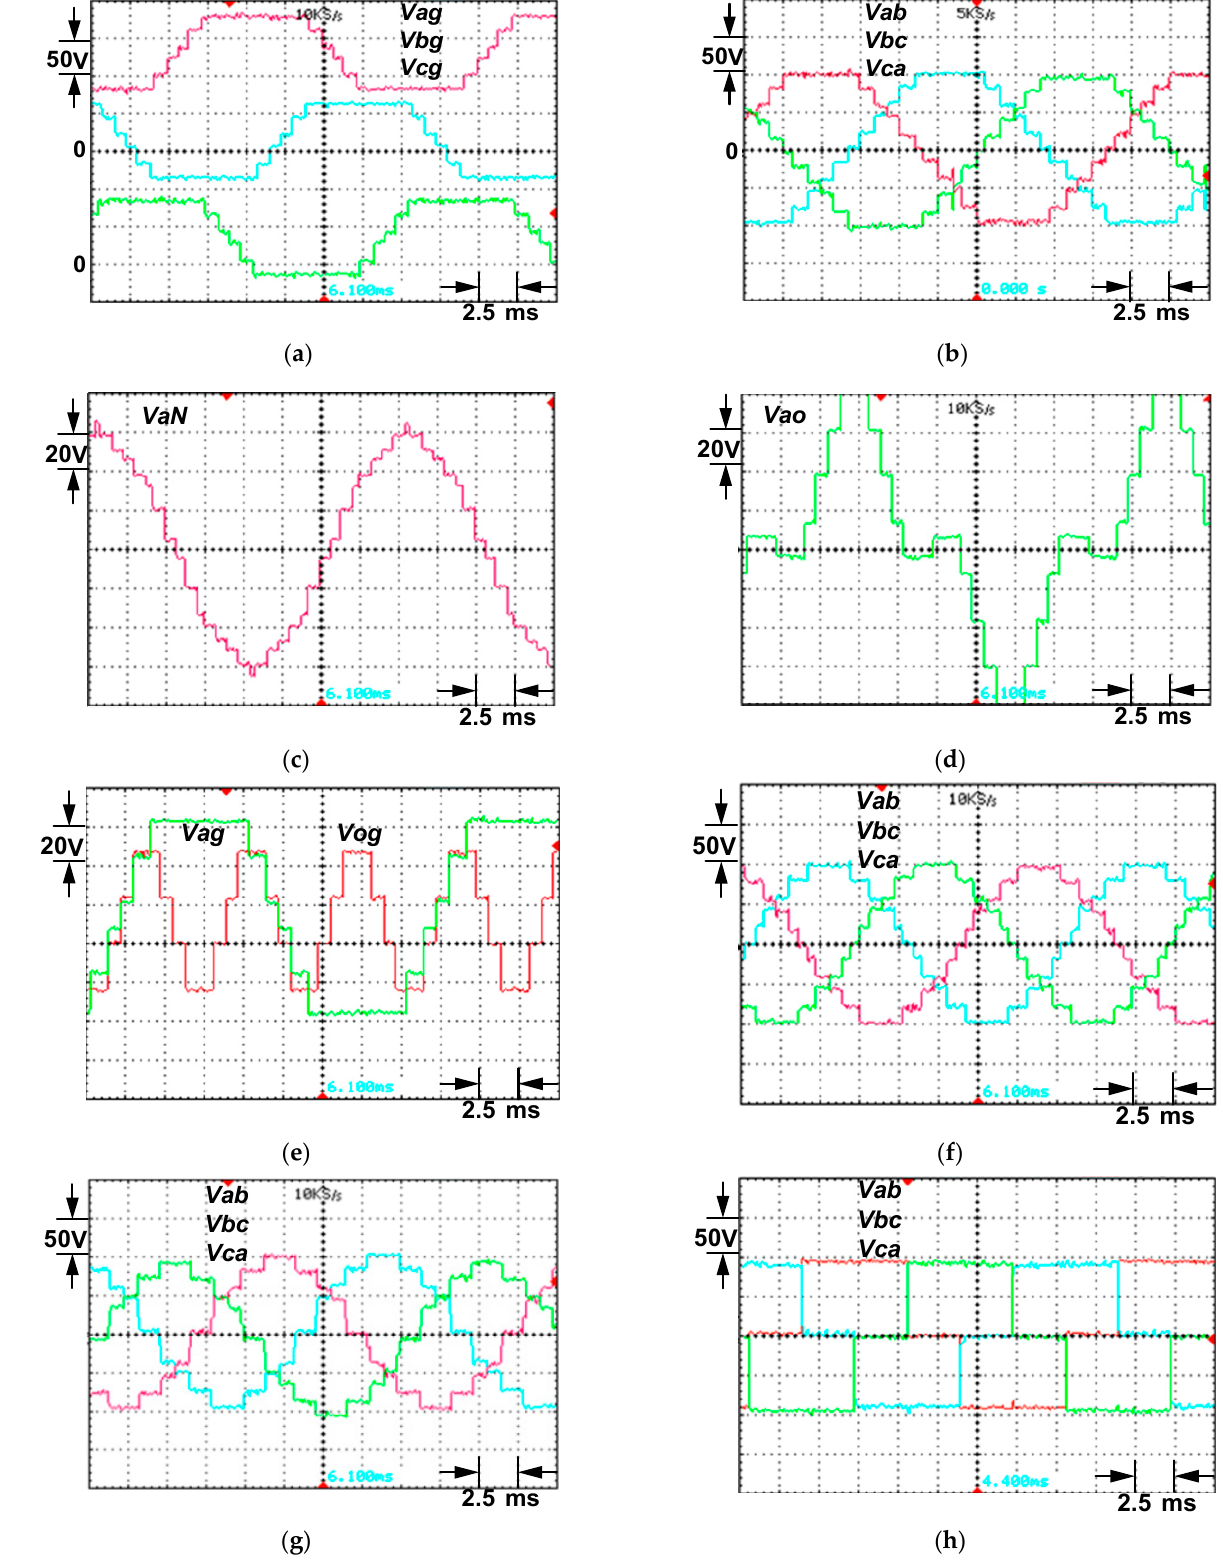
Figure 10. For Ma =1.3, the MLIs are: ( a ) line to ground voltages, ( b ) line to line voltages, ( c ) line to neutral voltage, ( d ) line